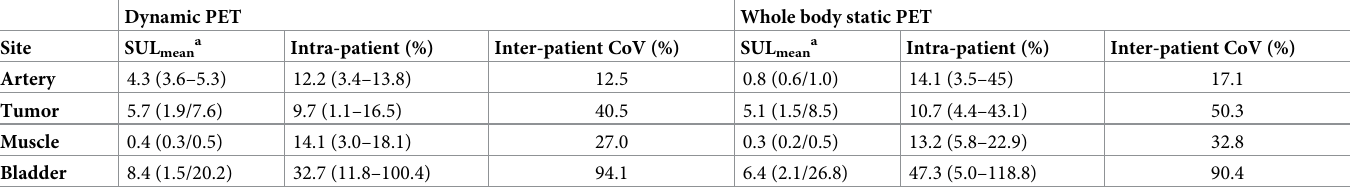
Table 2. Inter- and intra-patient variability in SUL mean of the dynamic and static PET. Data is shown as median (range). Dynamic PET Whole body static